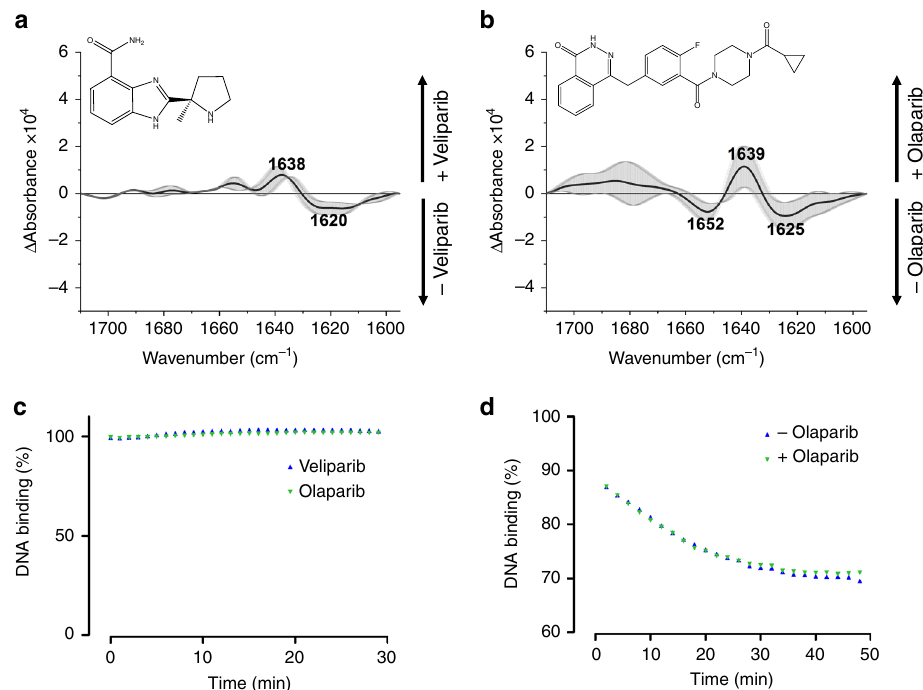
Fig. 6 Effect of inhibitor binding on PARP1 structure and DNA binding properties. a Secondary structure analysis of PARP1 upon binding to veliparib. Difference spectra of amide I bands of PARP1 bound to DNA blunt were calculated before and after the addition of 10 µ M veliparib. Average curves and SDs (grey) of two experiments are plotted. b Secondary structure analysis of PARP1 upon binding to olaparib. Difference spectra of amide I bands of PARP1 bound to DNA blunt before and after the addition of 10 µ M veliparib were calculated. Average curves and SDs (grey) of two experiments are plotted. c Evaluation of inhibitory effect of veliparib and olaparib. Dissociation of PARP1 from DNA blunt upon addition of 100 µ M NAD + in the presence of inhibitor was tested. Time-dependent intensity decrease of the amide II band (1548 cm − 1 ) was analysed. Intensity of the amide II band before addition of NAD + was set to 100%. d Analysis of ‘ trapping ’ effect of olaparib. Binding of PARP1 to immobilised DNA blunt was competed by the addition of free DNA blunt in the supernatant in the absence or in the presence of olaparib. Time-dependent intensity decrease of the amide I band (1645 cm − 1 ) was analysed. Intensity of the amide I band before addition of free DNA blunt was set to 100%. Source data are provided as a Source Data fi